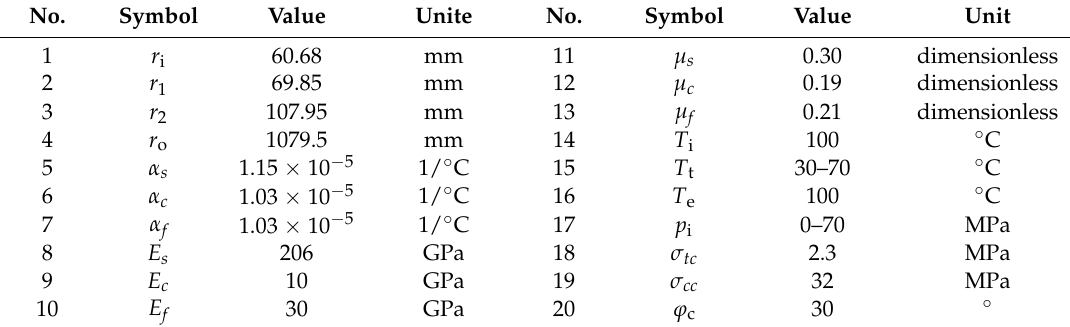
Table 2. Basic calculation